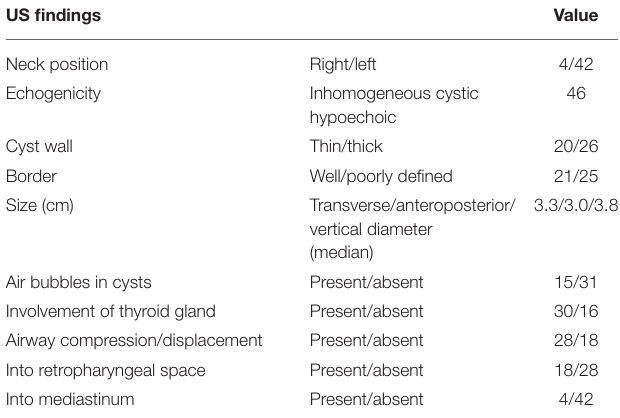
TABLE 1 | US findings of 46 lesions of CSPF.